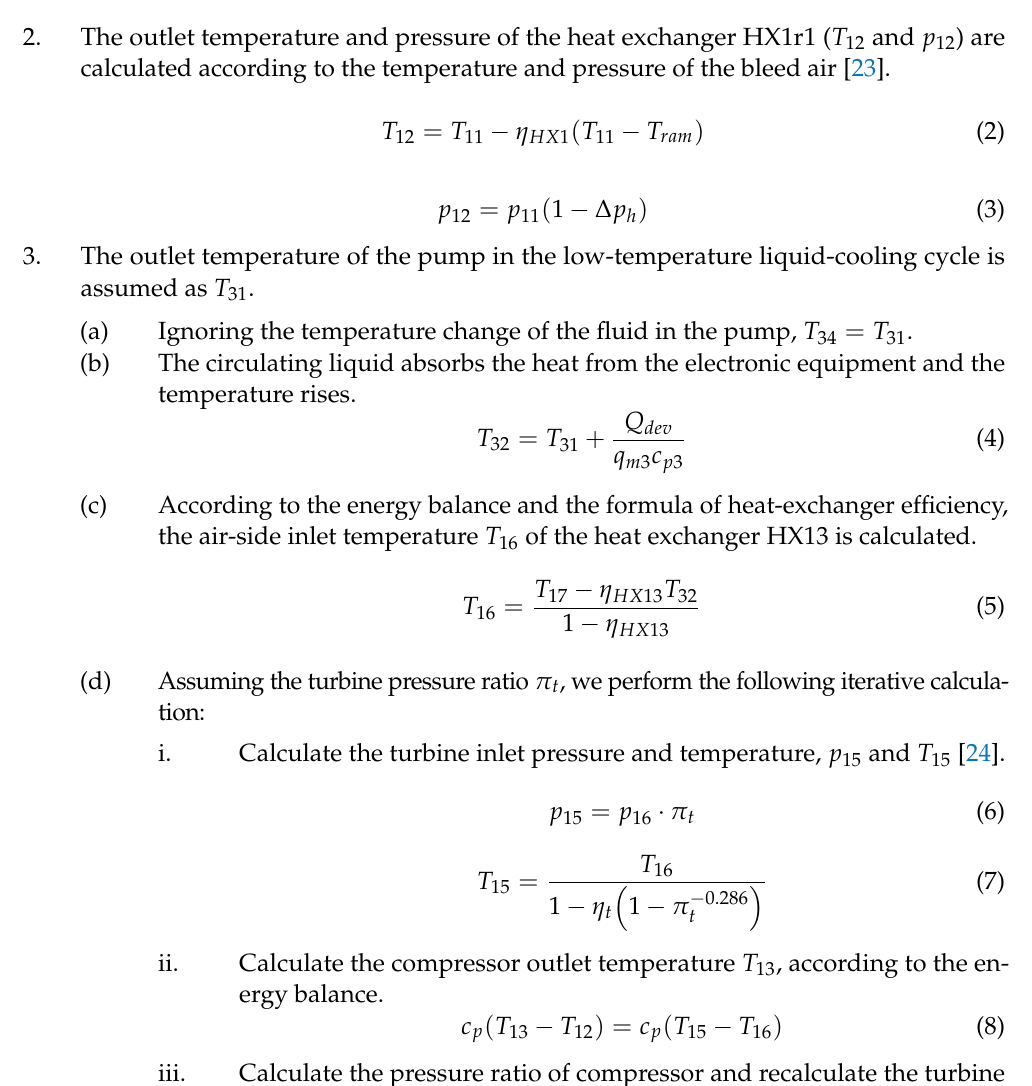
ii. Calculate the compressor outlet temperature T 13 , according to the en- ergy balance. iii. Calculate the pressure ratio of compressor and recalculate the turbine expansion ratio [24].